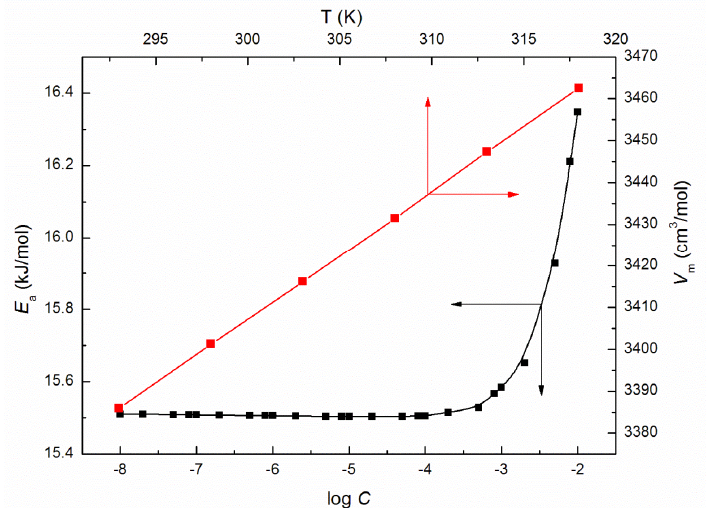
Figure 3. A plot of the values of the ln γ LV vs. 1/ η as well as η / η 0 vs. C for the aqueous solutions of ELP at T = 293 K.